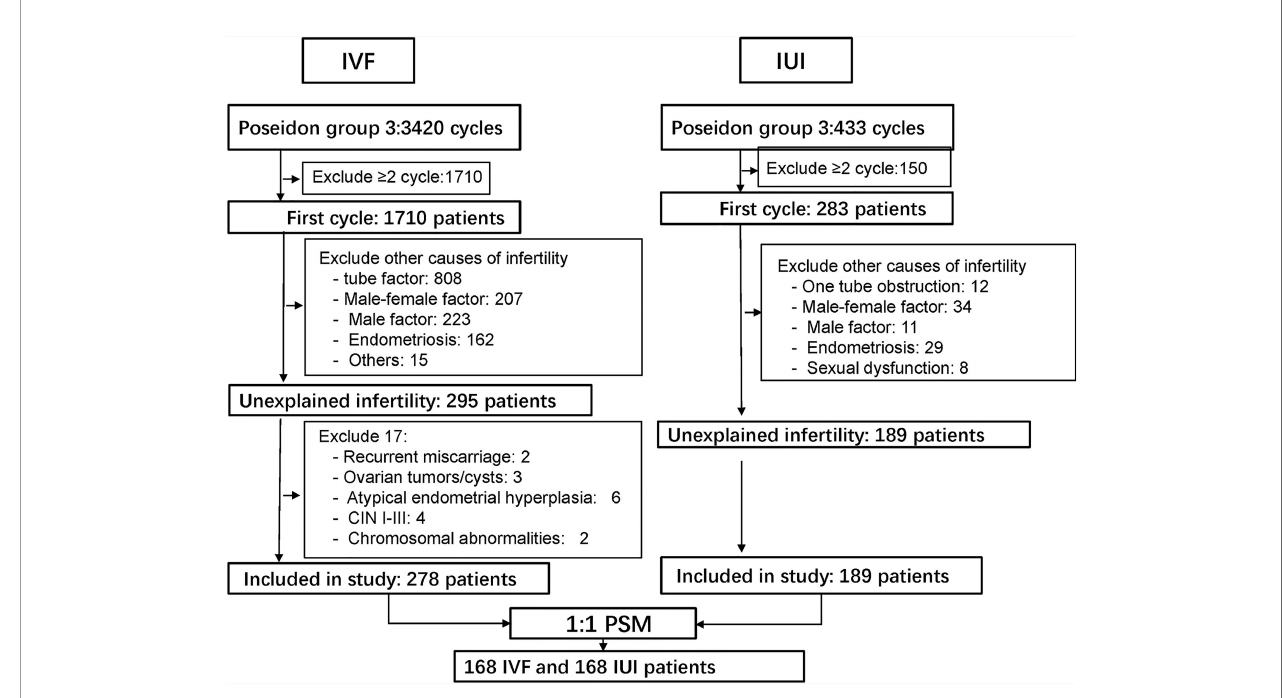
FIGURE 1 | Process of screening